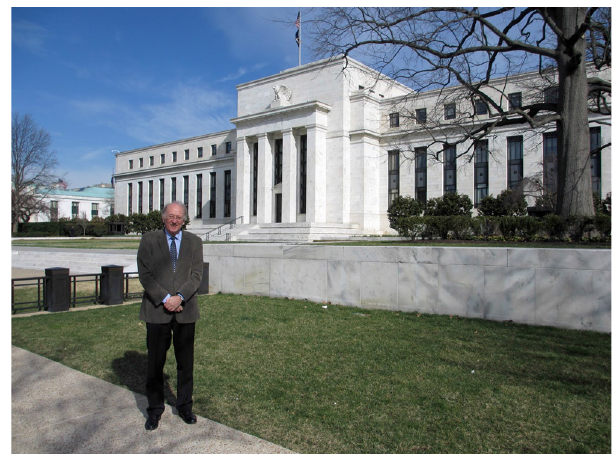
Figure 2: Paul Embrechts in 2014 in front of the FED building in